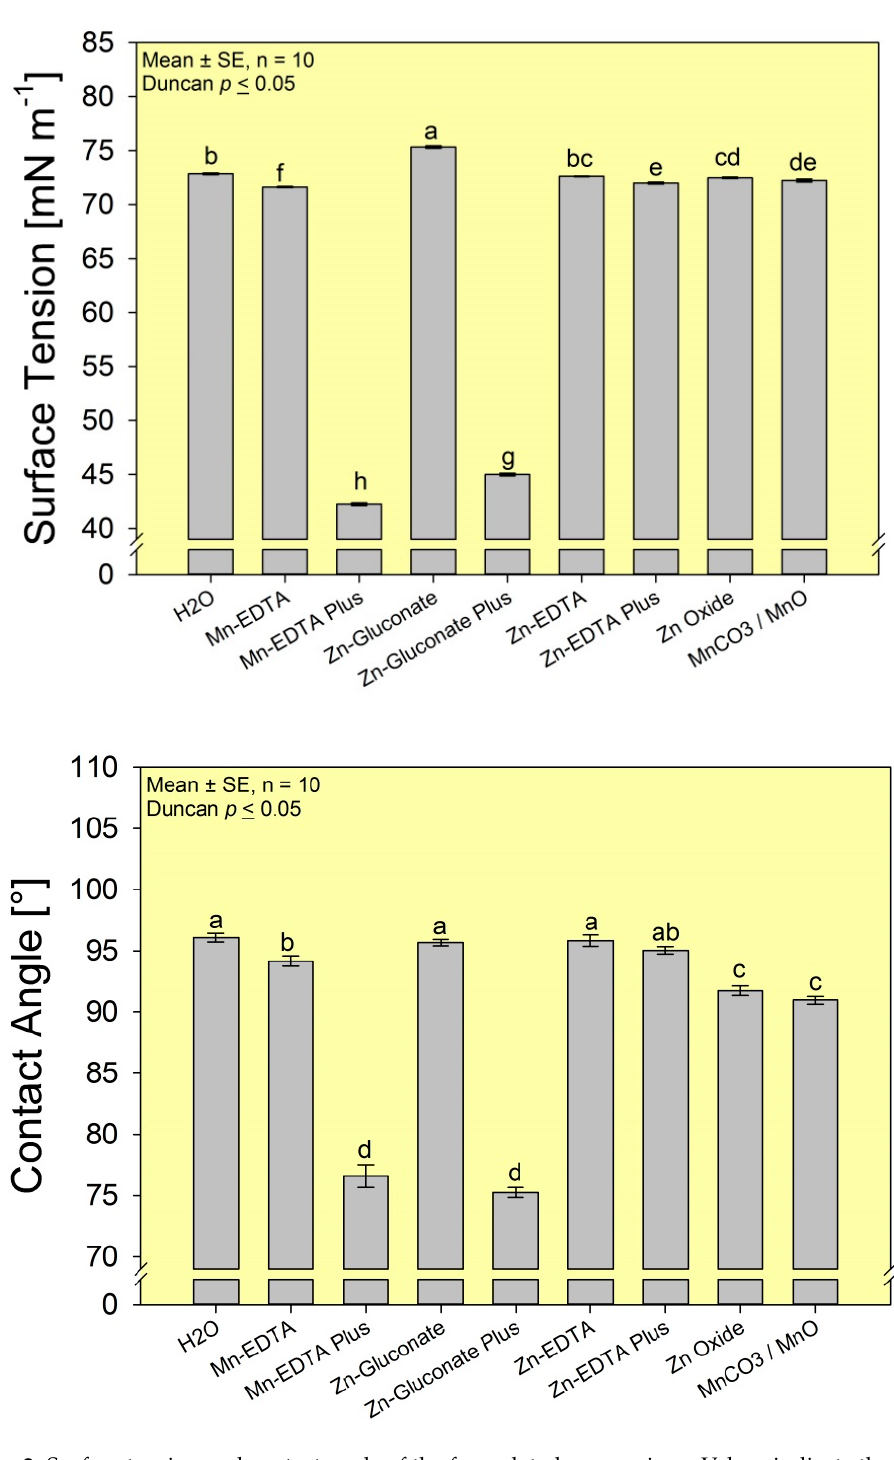
Figure 2. Surface tension and contact angle of the formulated suspensions. Values indicate the mean (± SE; n = 10). Means were separated according to the Duncan multiple range test ( p ≤ 0.05), values followed by different letters are statistically different.